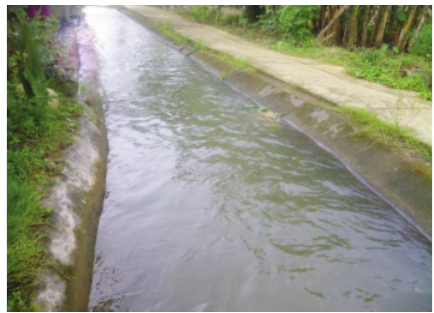
Figure 4: Irrigation canal for turbine